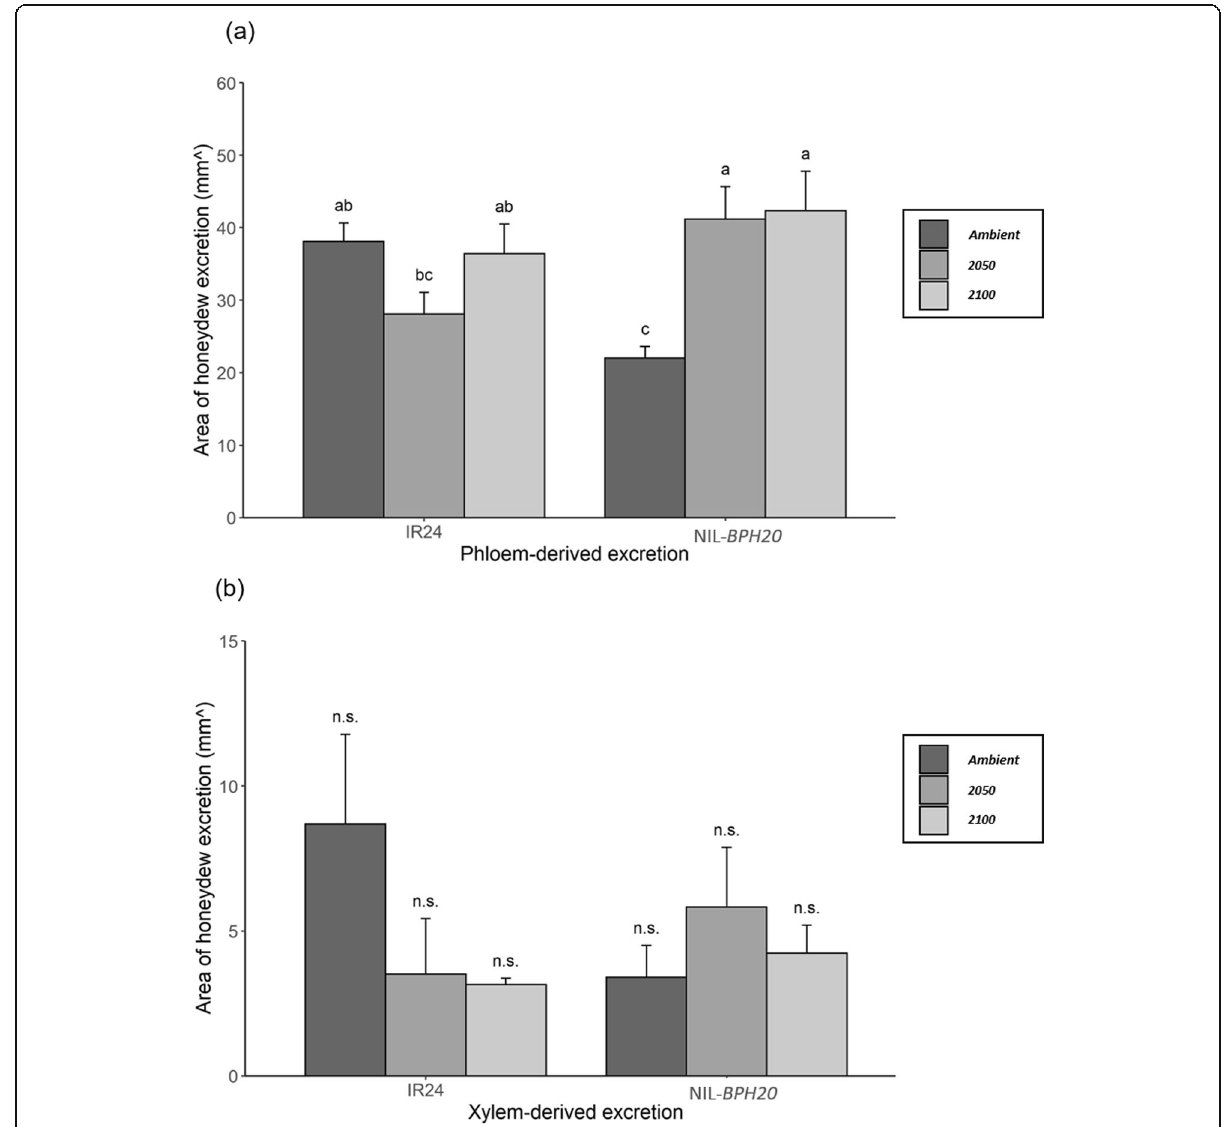
Fig. 2 Areas of honeydew excretion of N. lugens female feeding on IR24 and NIL- BPH20 under different environments. a Phloem-derived excretion. b Xylem-derived excretion. Means in each column followed by a different letter differ significantly ( P <